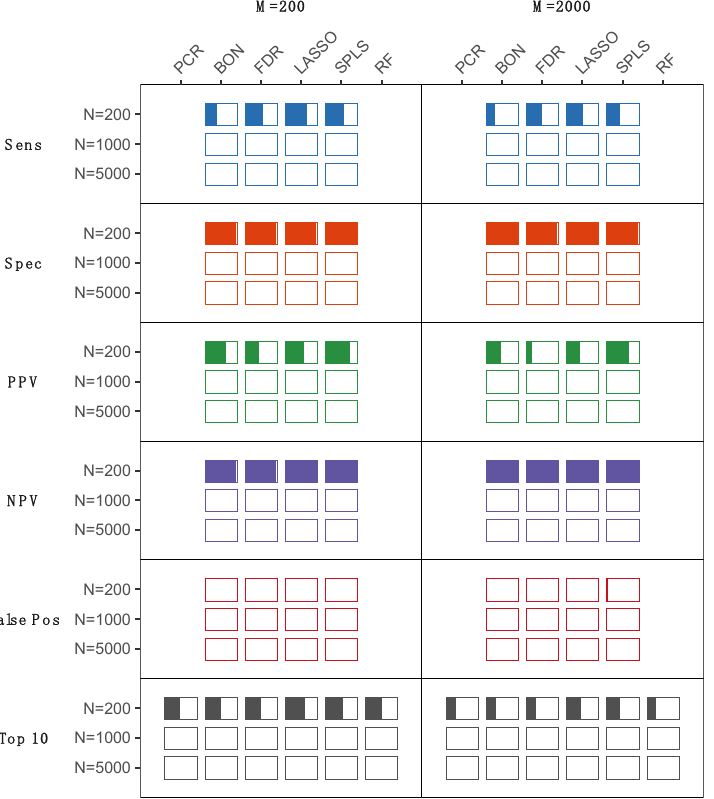
Figure 1. Results for a continuous outcome. The sensitivity, specificity, positive predictive value (PPV), negative predictive value (NPV), and false positive rate are displayed (as percent color fill of each bar) for each statistical method, reflecting their ability to correctly identify the top ten simulated metabolite associations across varying numbers of total metabolite measures (M = 200 or M = 2000) in study samples collected from varying numbers of study subjects (N = 200, N = 1000, or N = 5000). PCR, principal components regression; BON, Bonferroni; FDR, false discovery rate; LASSO, least absolute shrinkage and selection operator; SPLS, sparse partial least squares; RF, random forest.